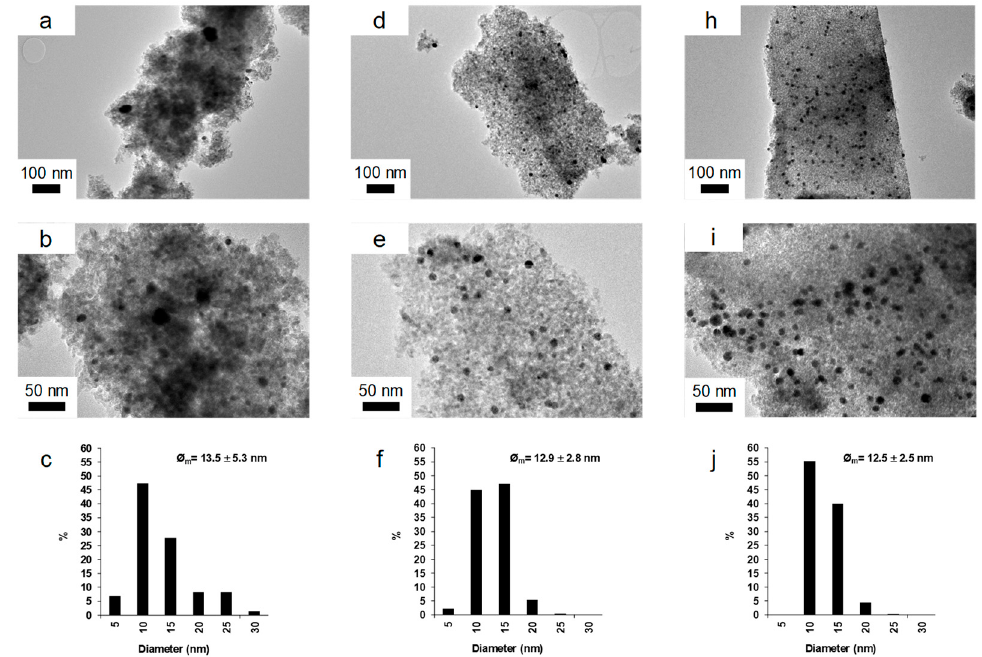
Figure 4. Transmission electron microscopy (TEM) images at magnification of × 25,000 (Scale bar = 100 nm) and × 62,000 (Scale bar = 50 nm) and size distribution of ( a – c ) TiO 2 @Au, ( d – f ) TiO 2 @Au-RB, ( h – j ) TiO 2 @Au-HP.